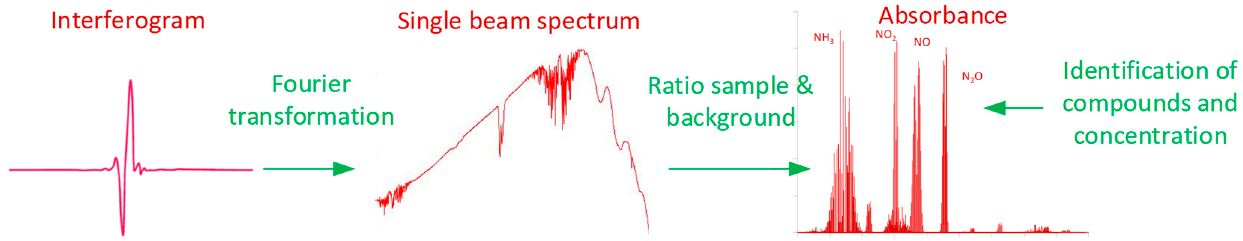
Figure 3. Processing of an interferogram.